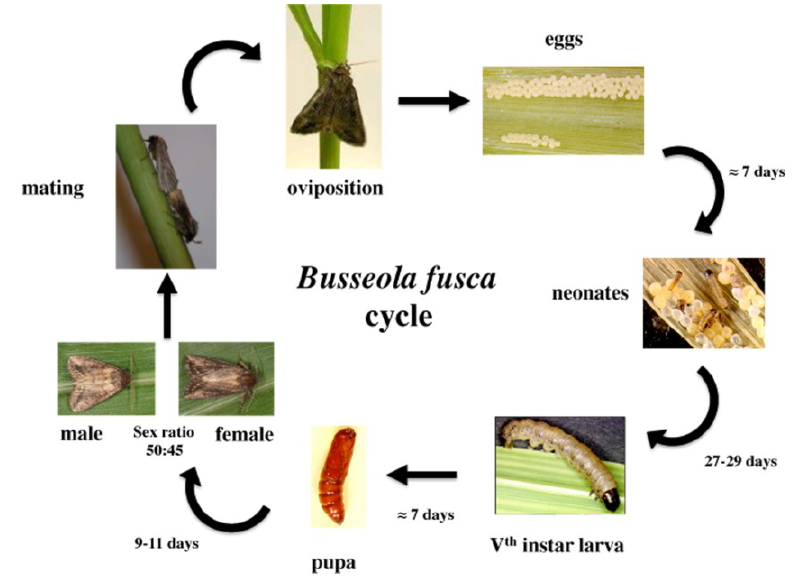
Figure 1. Biological cycle of Busseola fusca under optimal environmental conditions on artificial diet (photos on mating and oviposition from